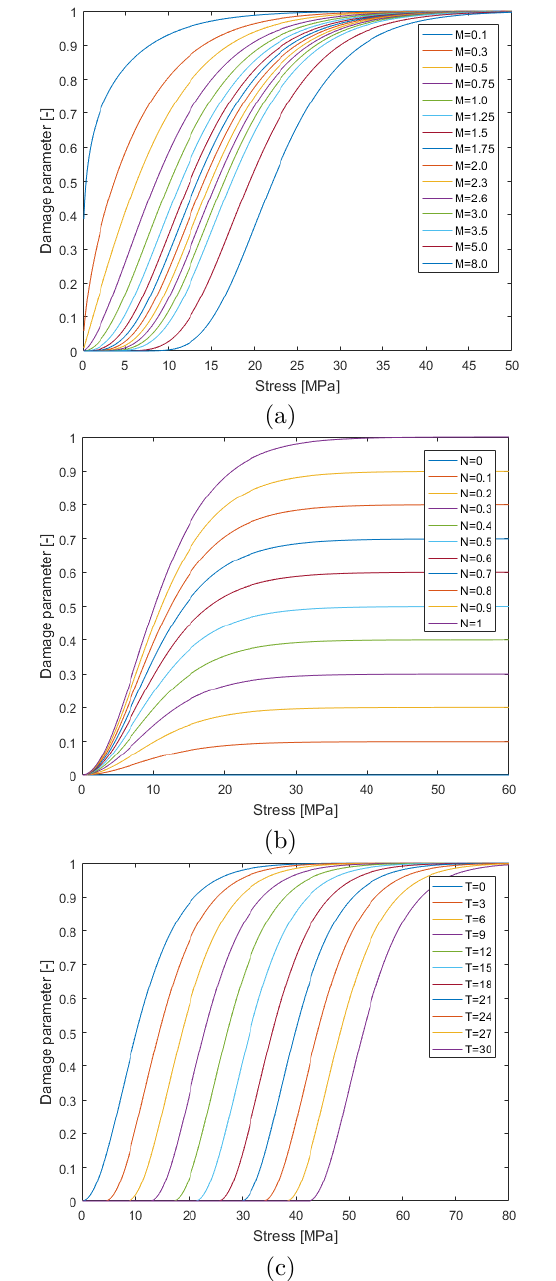
Figure 11. Influence of parameters M, N in describ- ing the evolution of ω according to Eq. (16): (a) in- fluence of parameter M , N =1, T =0; (b) influence of parameter N , M =1, T =0; (c) influence of parameter T , M = N =1.